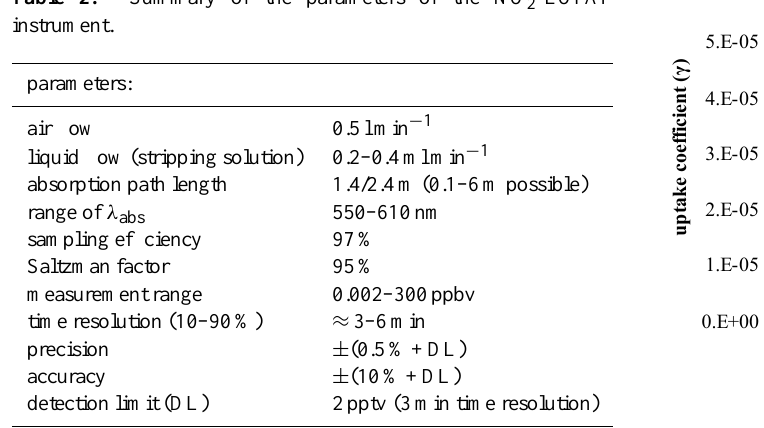
Table 2. Summary of the parameters of the NO 2 -LOPAP